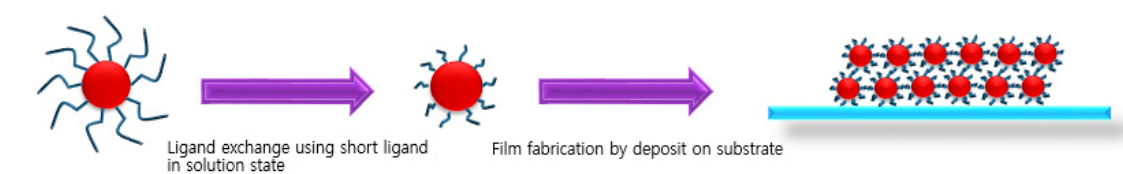
Figure 5. Schematic of the solution-phase ligand exchange and film fabrication. Ligands of CQDs are exchanged in the solution-phase first. After that, CQD films can be fabricated just by spin-coating the CQD inks on the substrate.